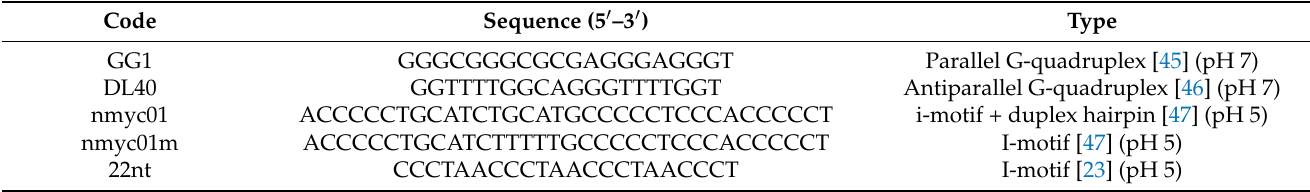
Table 1. Sequences of measured